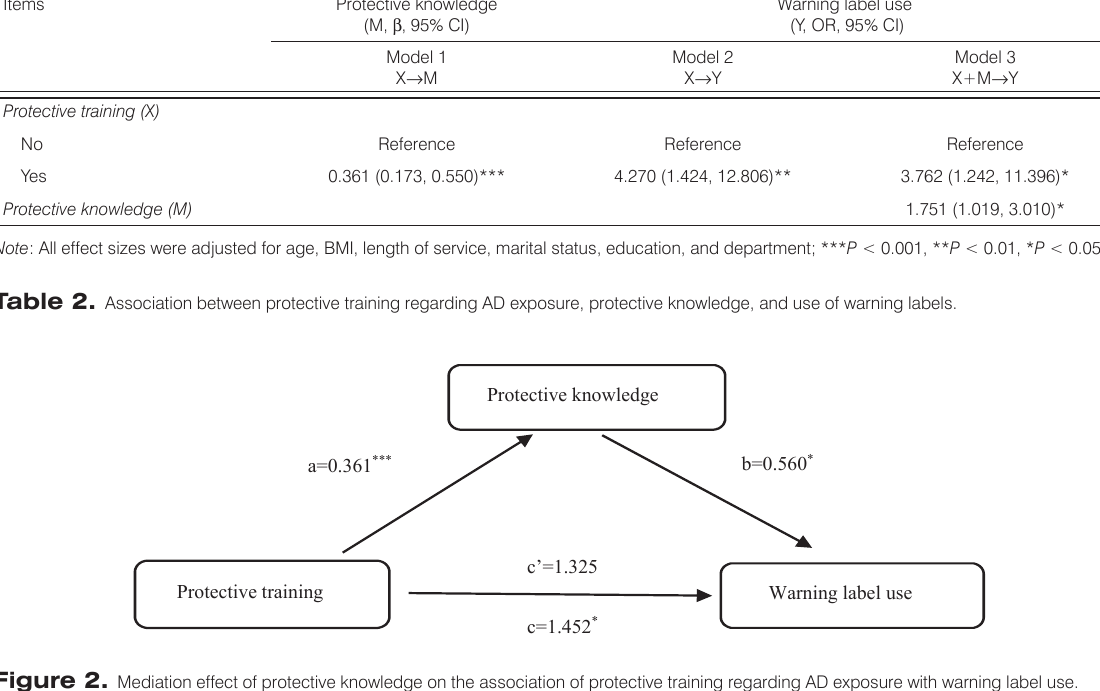
CI indicated that protective knowledge significantly mediated the association between protective training and protective mask use (indirect effect = 0.157, 95% CI: 0.048, 0.325), and the proportion of mediation was 27.2% (Figure 3).